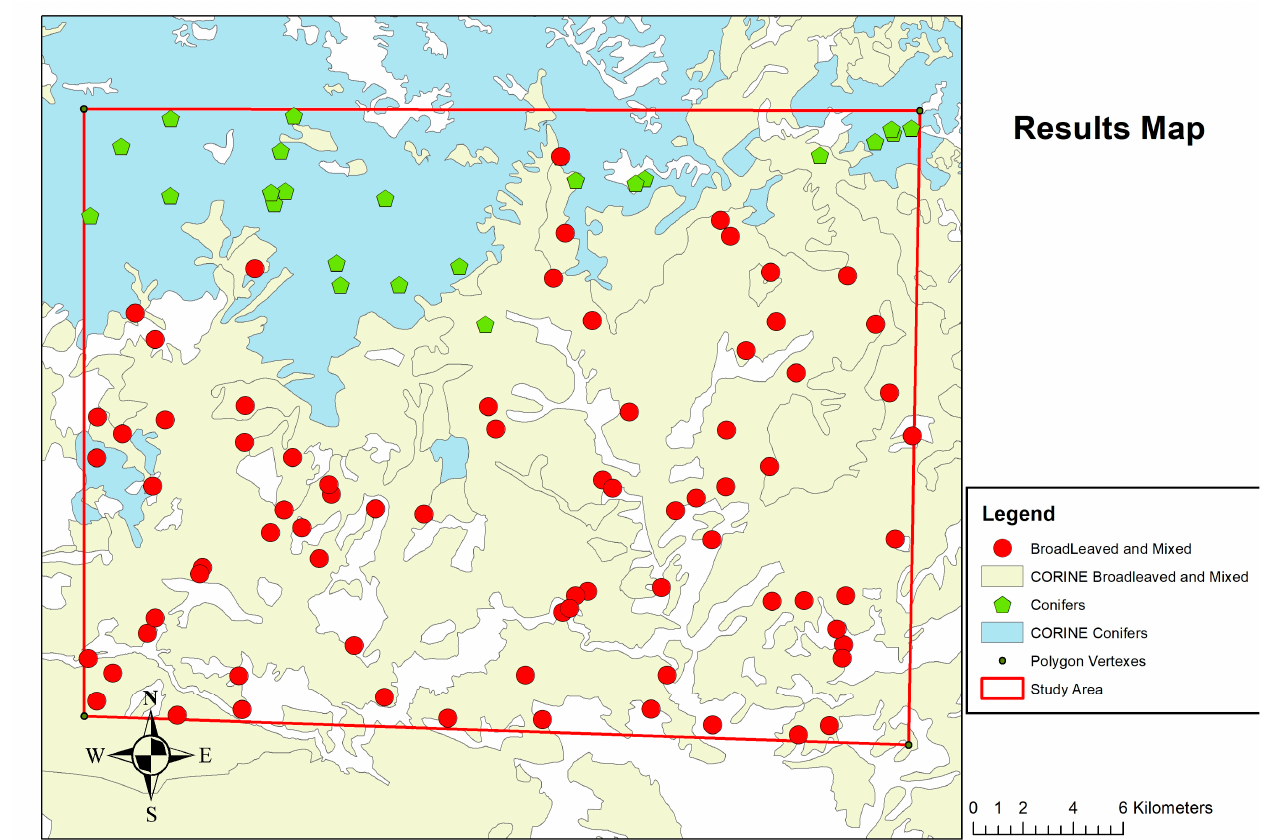
Figure 8. Results comparison with CORINE 2018